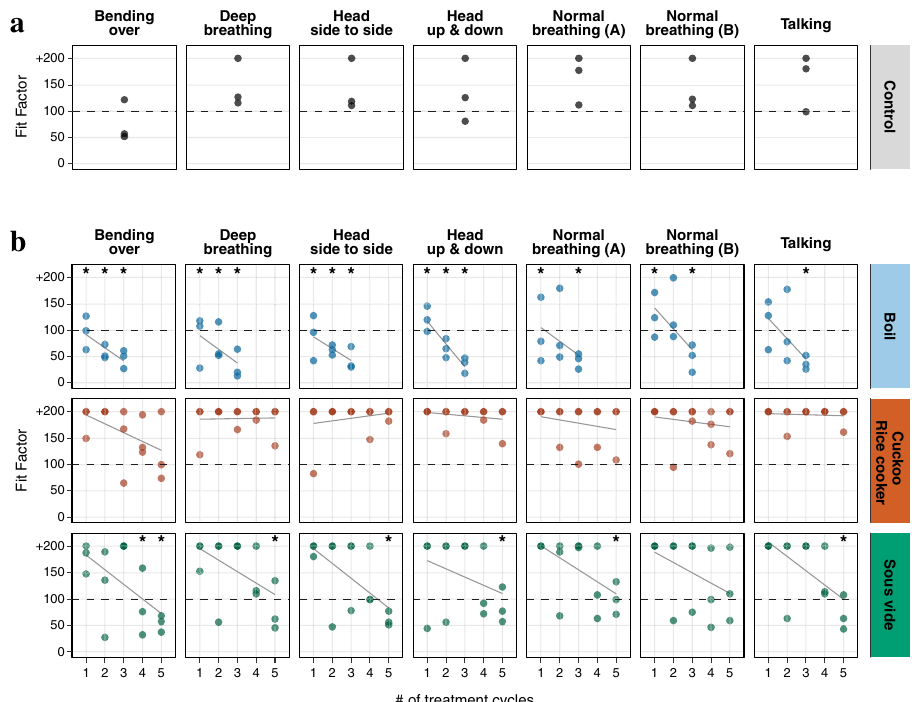
Figure 3. Halyard Fluidshield 3 FFR fit for seven standardized testing conditions. The fit of control ( a ) and heat-treated ( b ) FFRs was assessed three times in each of seven testing conditions (individual dots) for each heat-treatment and control group. Grey lines in ( b ) signify linear regression fit of fit factor over treatment cycle (Supplementary Tables S7 and S8). Asterisks indicate significant differences in mean fit between treatment group and control (ANOVA, p <